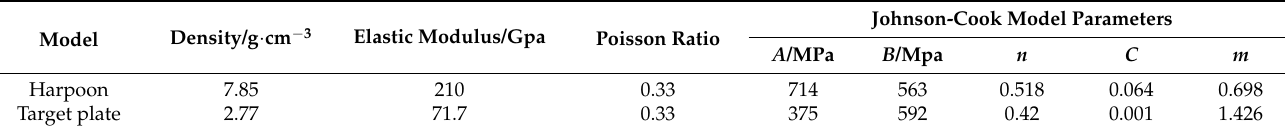
Table 1. Harpoon and target plate material parameters.